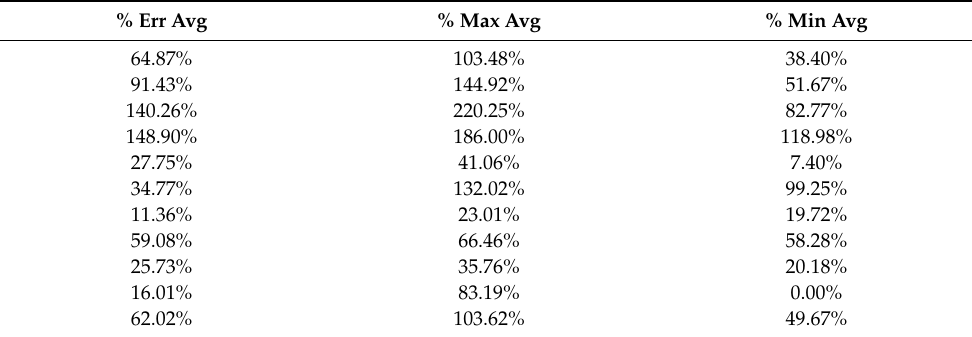
Table A151. Set 2, trials 41–50 data (all 0.5 PR values).